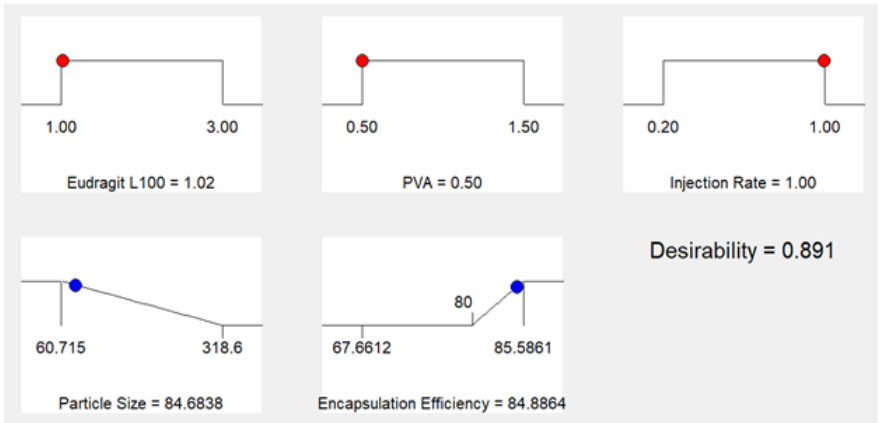
Figure 5. Values generated by design expert for development of optimized nanoformulation.